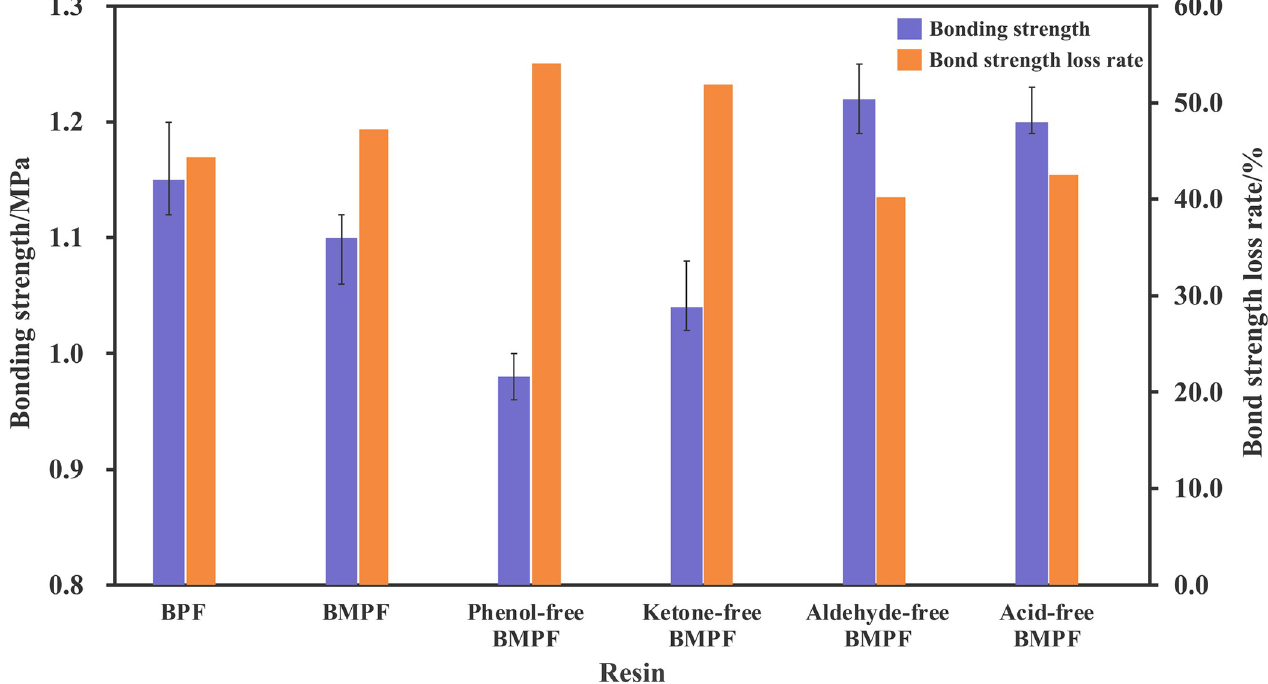
Fig 3. Bonding strength and its loss rate of BMPF